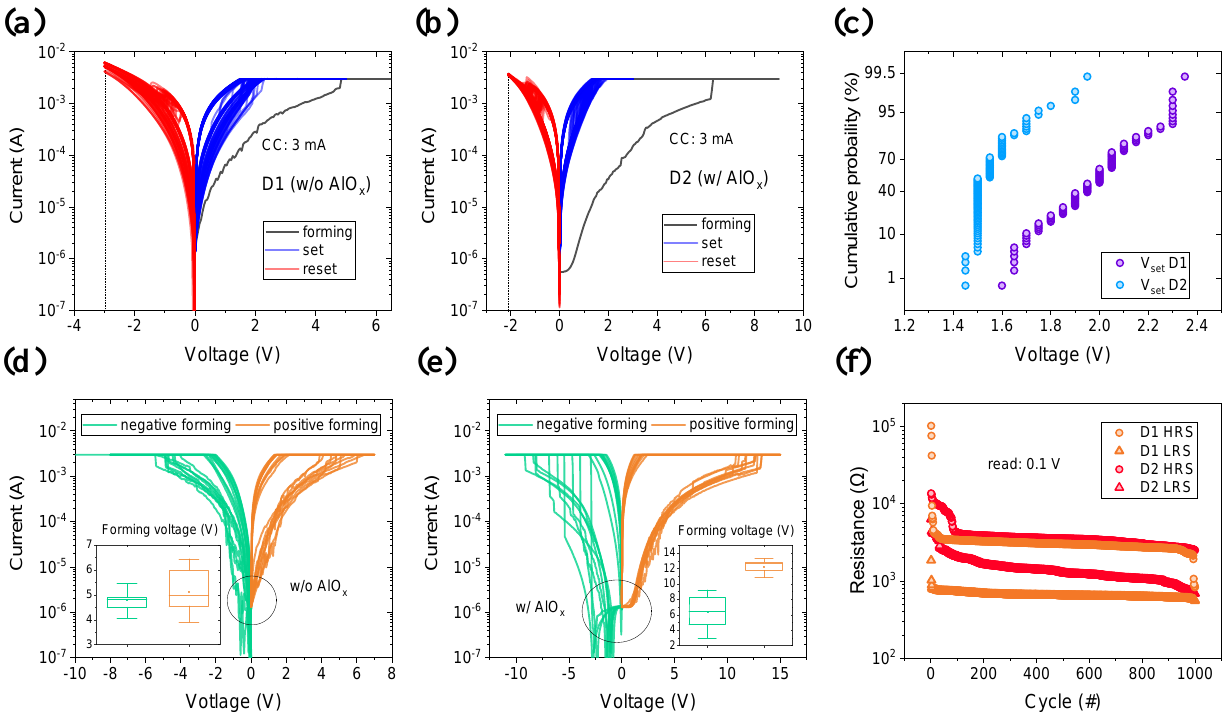
Figure 2. The I-V curve of ( a ) ITO/WO x /TaN device 1 and ( b ) ITO/WO x /AlO x /TaN device 2 during 100 cycles. The black lines indicate the forming process, the red lines indicate the reset process, and the blue lines indicate the set process. ( c ) The cumulative probability of set voltage. A blue circle group is device 1 and a purple circle group is device 2, respectively. The forming process of ( d ) device 1 and ( e ) device 2 was performed by negative or positive bias. Each inserted figure shows a forming voltage range at 3 mA. ( f ) Switching endurance of D1 (orange) and D2 (red) during 1000 cycles. The reset voltage, which is the maximum voltage, allows the switching